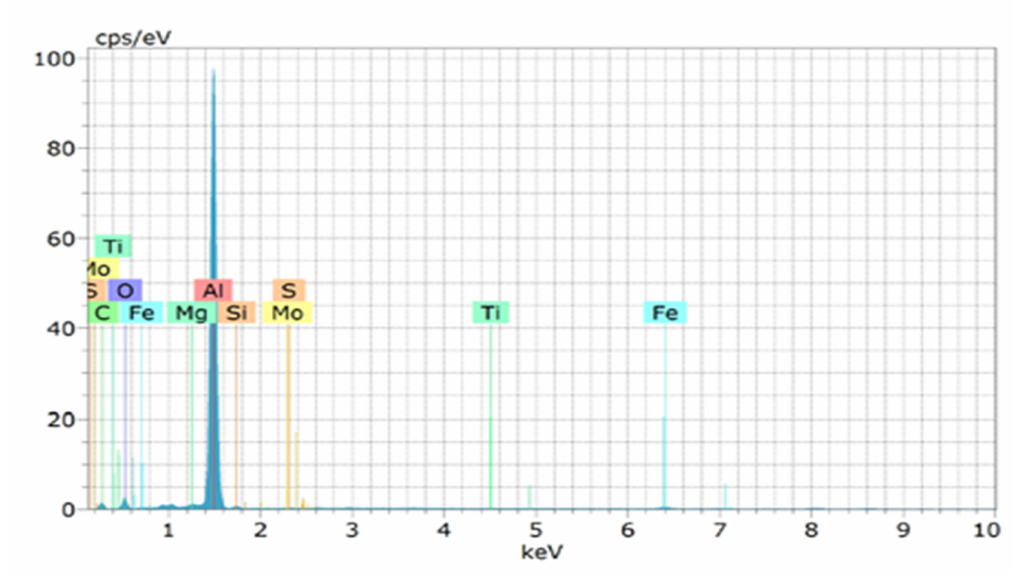
Figure 6. Energy dispersive X-ray spectroscopy of Al − 10 % TiB 2 − 0.3 % graphene.